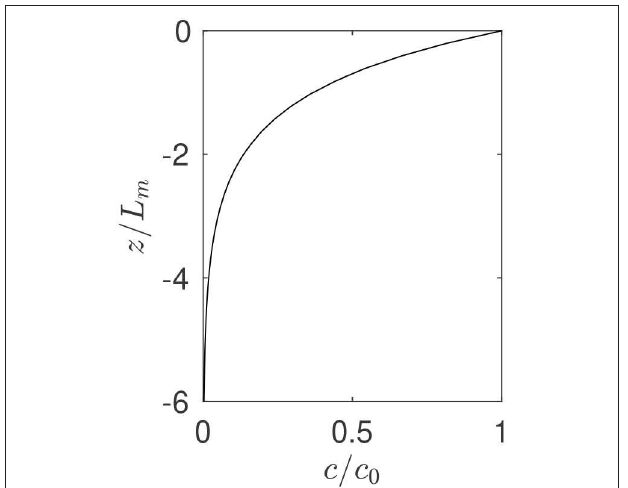
τ p w p / g , and the relevant flow time scales are the wave period = T and the Kolmogorov timescale of the turbulence τ η . Thus,